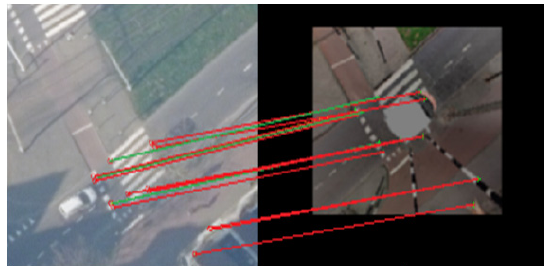
Figure 13 Förstner/SURF matching result of 9 th tile